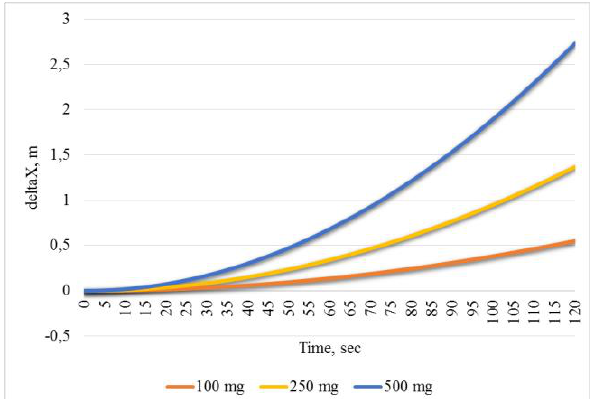
Figure 6. Accelerometers errors accumulation along X axis